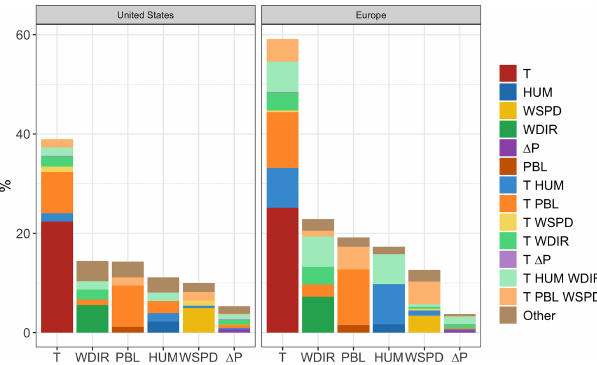
Figure 7. Unique and shared contributions to O 3 correlation for each of six different meteorological variables in the BASE case. Column heights represent overall predictive power for each vari- able, while individual colors indicate predictive power unique to that variable (bottom color in each column) or shared by one or more other meteorological variables.